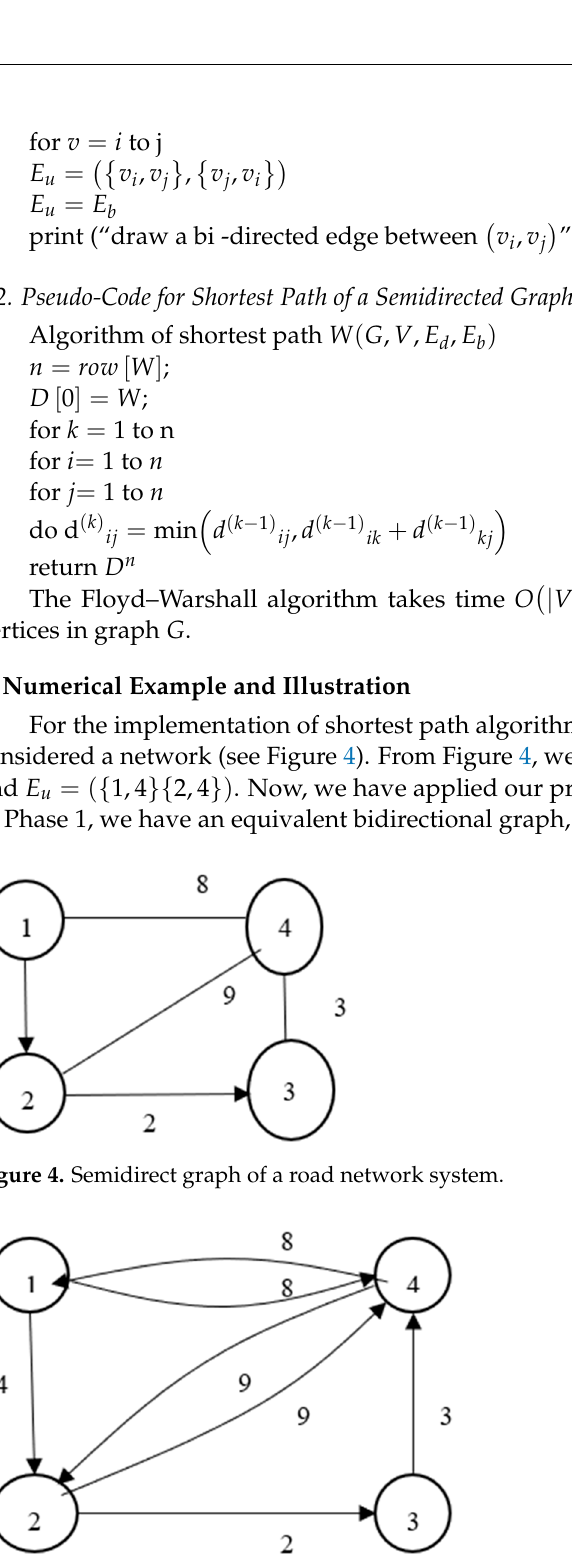
Figure 5. Equivalent bidirectional graph of semidirected graph.